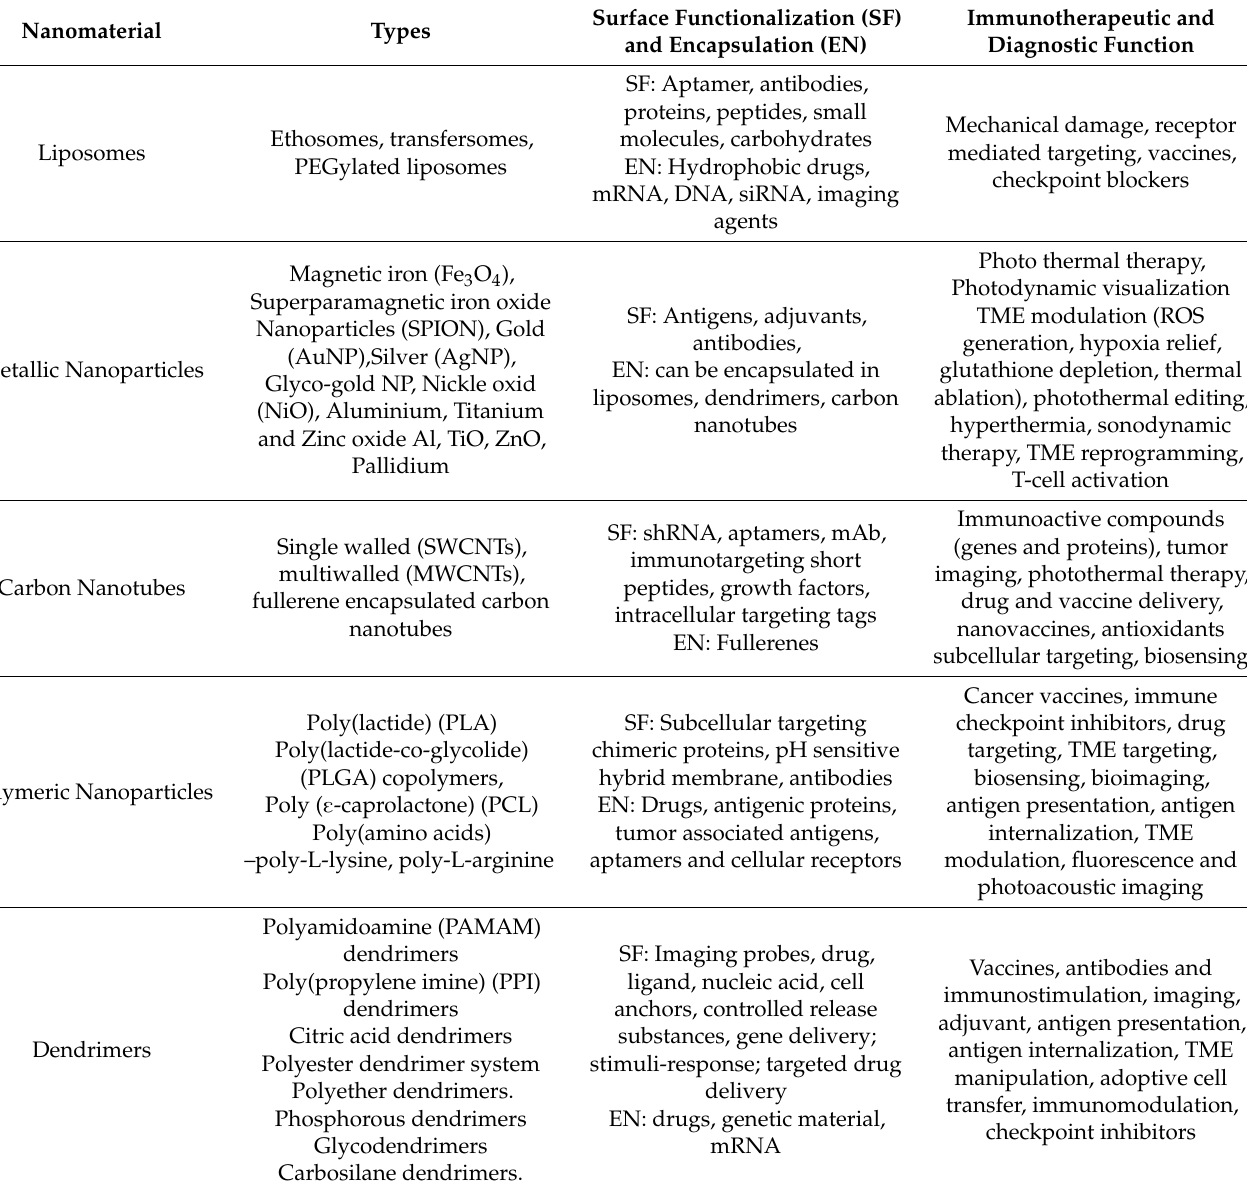
Table 1. The above table lists some types of nanoparticles commonly used in immunotherapeutic modules against various cancers. It lists the modes of surface functionalization (SF) and encapsulation (EN) with drugs, peptides, nucleic acids, etc. The immunotherapeutic and diagnostic functions of each type of nanomaterial are